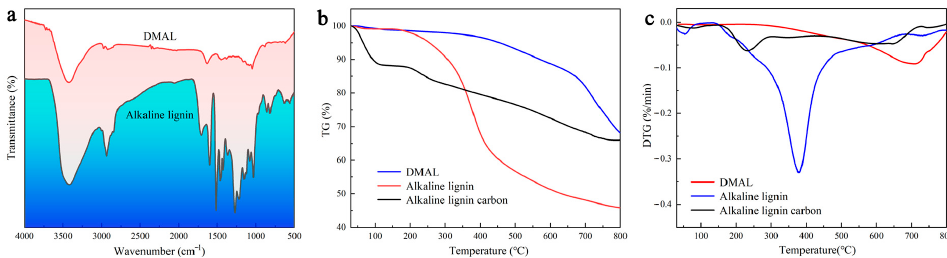
Figure 1. ( a ) IR spectrum of DMAL with alkaline lignin, ( b ) TG curve of DMAL with alkaline lignin, ( c ) DTG curve of DMAL with alkaline lignin. ( c ) DTG curve of DMAL with alkaline